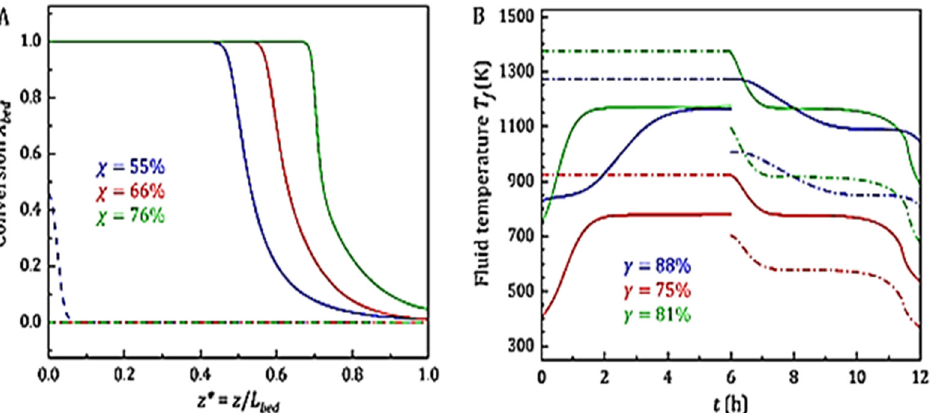
Figure 12. ( A ) Bed conversion efficiency and ( B ) fluid temperature of fixed-bed reactors. In ( A ), conversions at the start of charging (t = 0) are shown as dashed lines, and those at the end of charging (t = 6 h) as solid lines. In ( B ), fluid temperatures at the inlet are shown as dash-dotted lines, and those at the outlet as solid lines (blue: Mn 2 O 3 , red: Ca(OH) 2 , green: CaCO 3 ) [131].